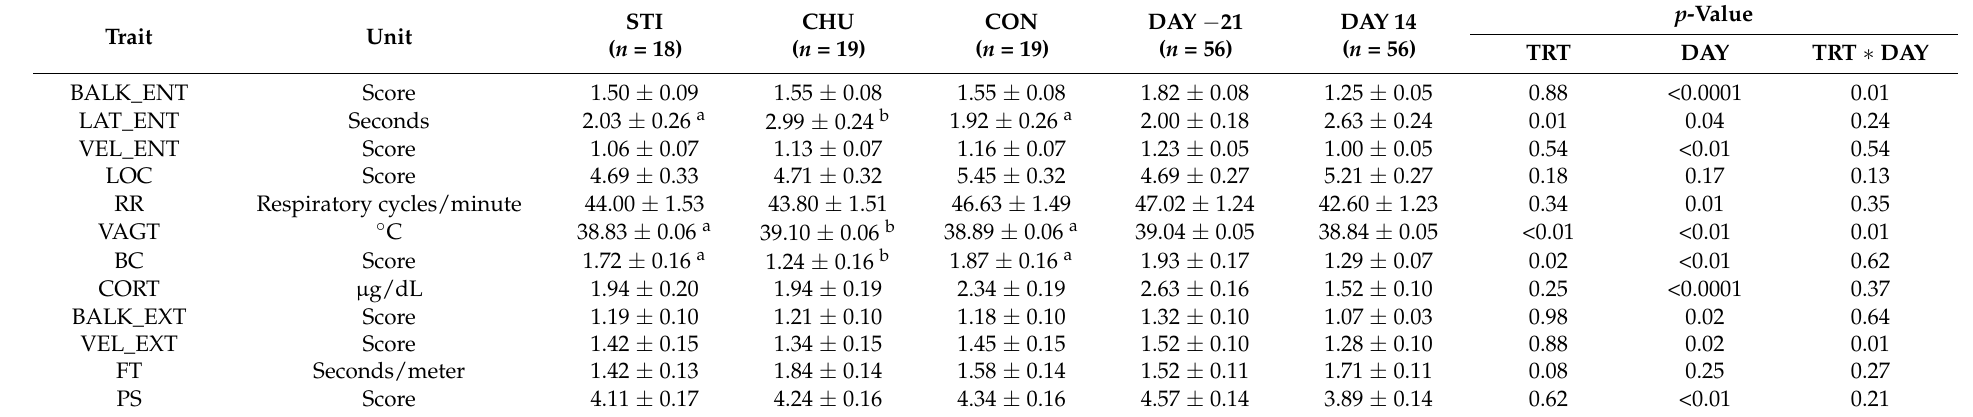
Table 4. Effects of treatment, day of sampling and their interaction on behavioral and physiological parameters of Bos taurus beef cattle ( n = 56).